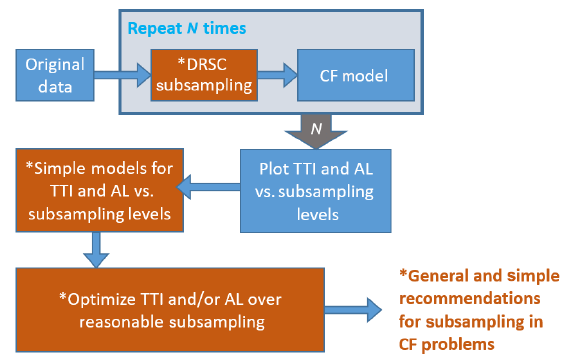
Fig. 1 Overview of